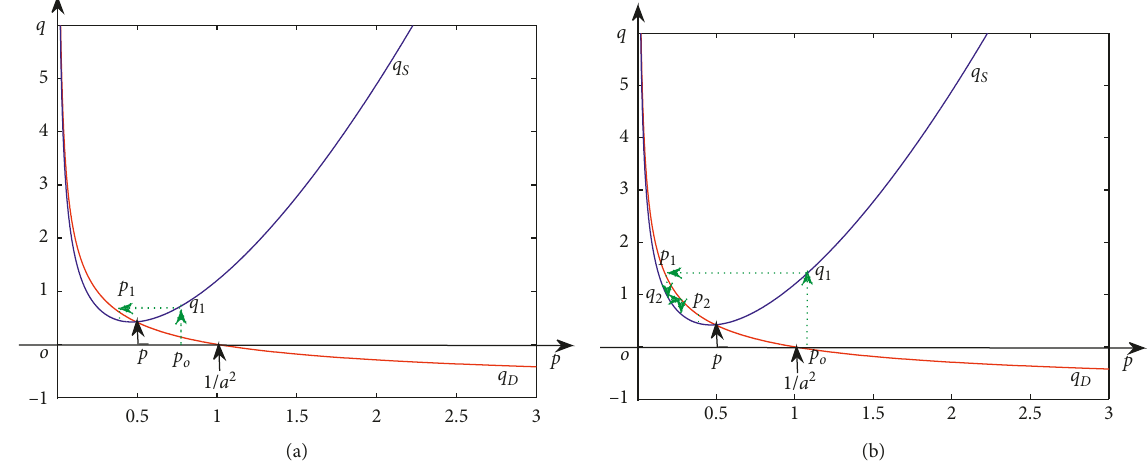
Figure 1: The dynamics of price and quantity represented by the cobweb diagram at different initial values of price. The other values are as follows: a 1 ,c 0 . 2 ,k 1 . 5. (cid:28) (cid:28) (cid:28)